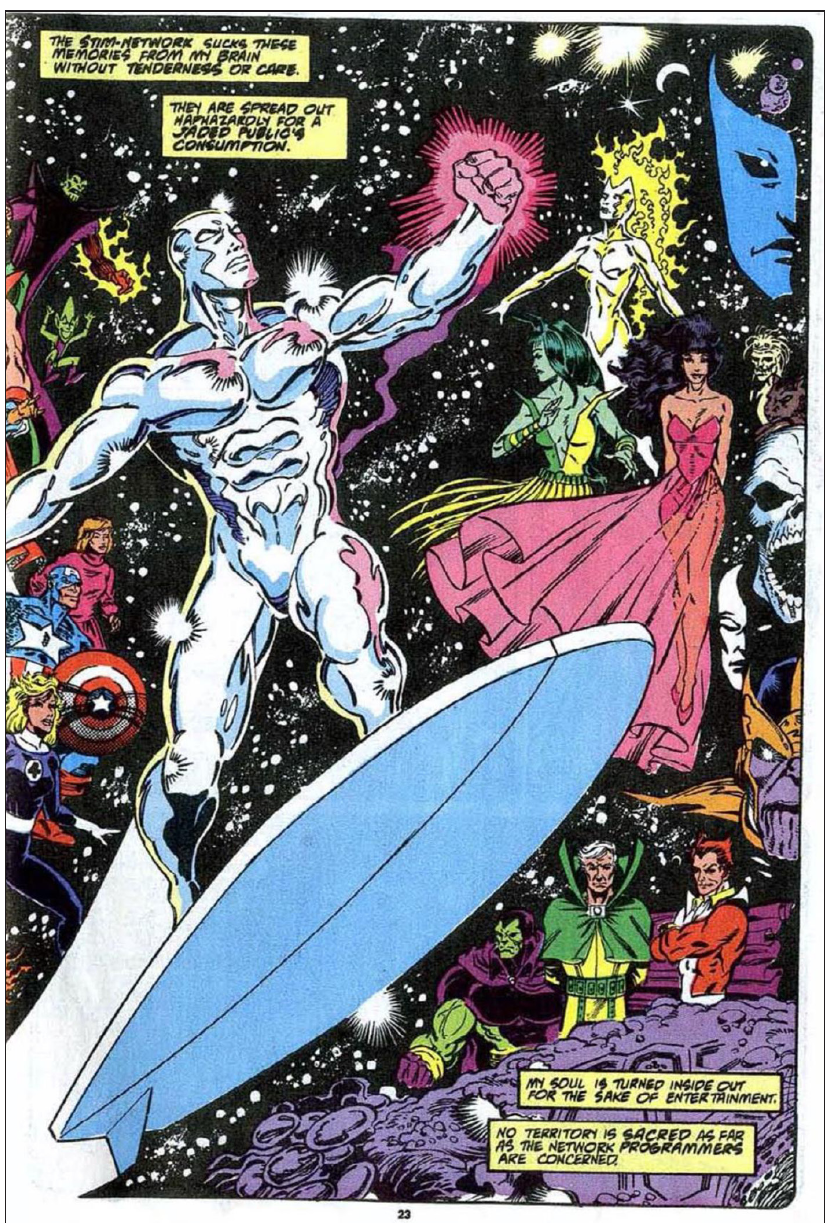
Figure 4: The Silver Surfer #41. New York: Marvel, 1990, p. 23. Jim Starlin (writer), Ron Lim (penciler), Tom Christopher (inker), Ken Bruzenak (letterer), Tom Vincent (colorist), Craig Anderson (editor), Tom Defalco (Chief). © 1990 Marvel Entertain- ment Group,